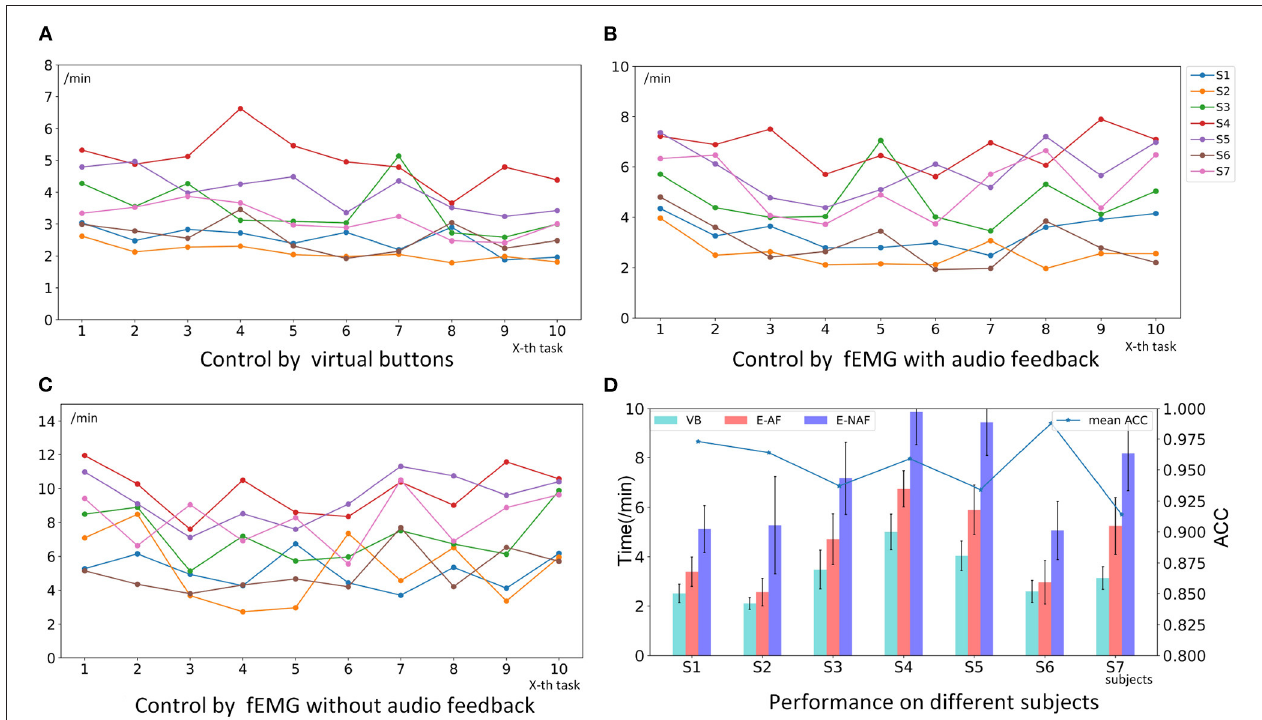
FIGURE 11 | The performance of different subjects using different methods to control the robotic arm to complete the task of drinking water online. (A) Control by virtual buttons (VB). (B) Control by fEMG with audio feedback (E-AF). (C) Control by fEMG without audio feedback (E-NAF). (D) Performance on different subjects. The bars represent the average time-consuming of 10 online tasks, and the broken line represents the average recognition accuracy (ACC) of 5 cross-validation using Gradient Boosting Classifier (GBC) with elected features (EF) {RMS, MAC, VAR} as input when offline.